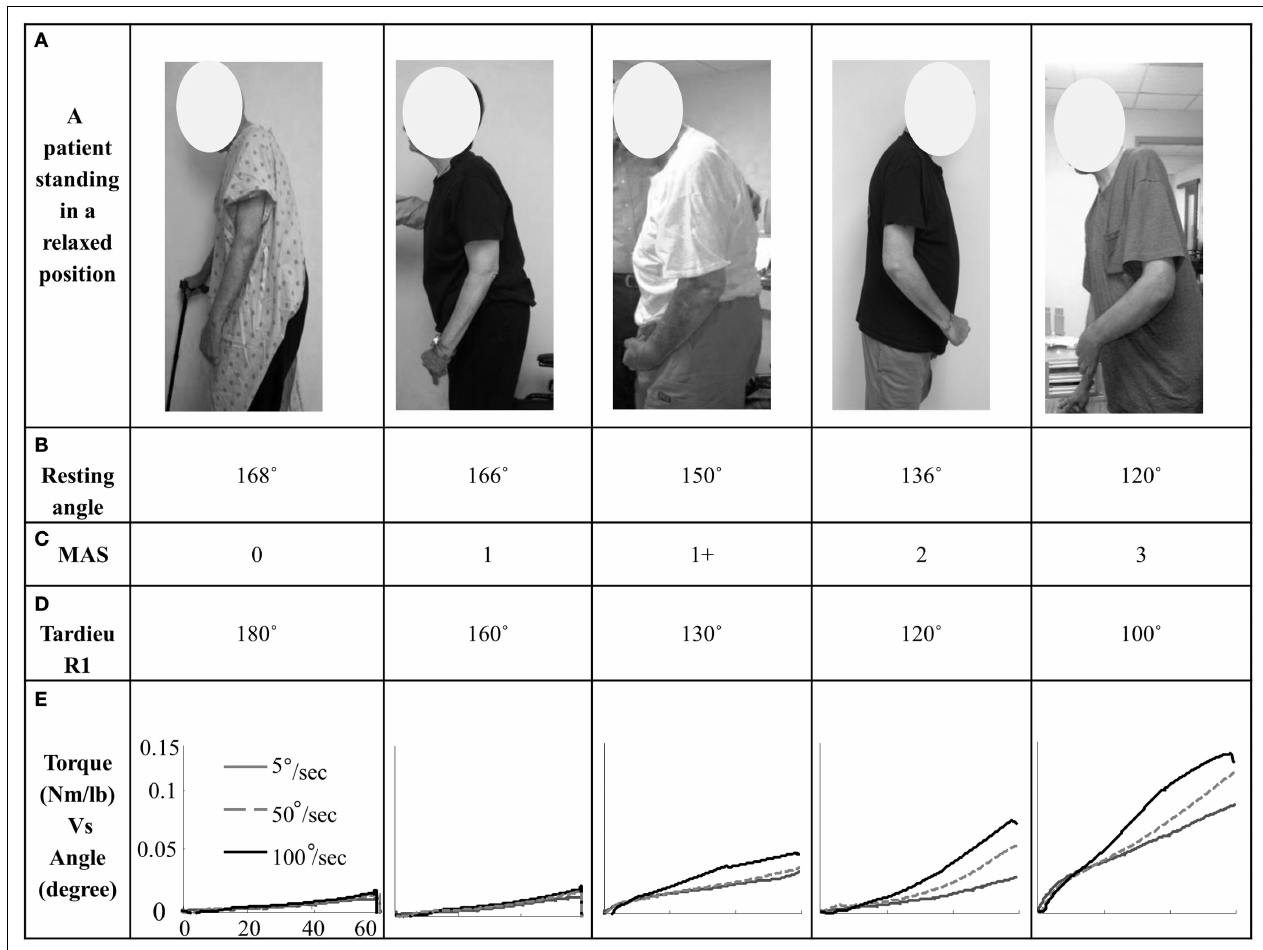
FIGURE 2 | (A) A stroke patient (representing each MAS score group) standing in a relaxed position; (B) resting angle in degrees; (C) MAS score; (D) Tardieu R 1 angle in degrees; (E) torque–angle response (mean of three trials) for the speeds 5, 50, and 100°/s for each subject of a representing MAS score group.